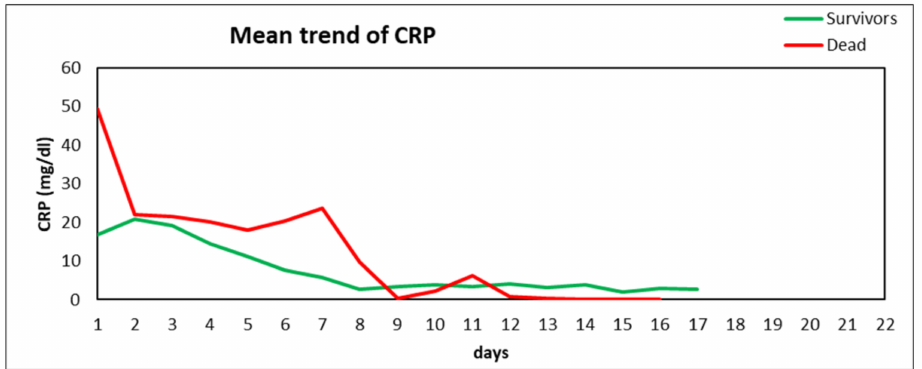
Figure 2. CRP trend during ICU stay of survivors and non-survivors ( p = NS) during days of ICU stay. NS: not